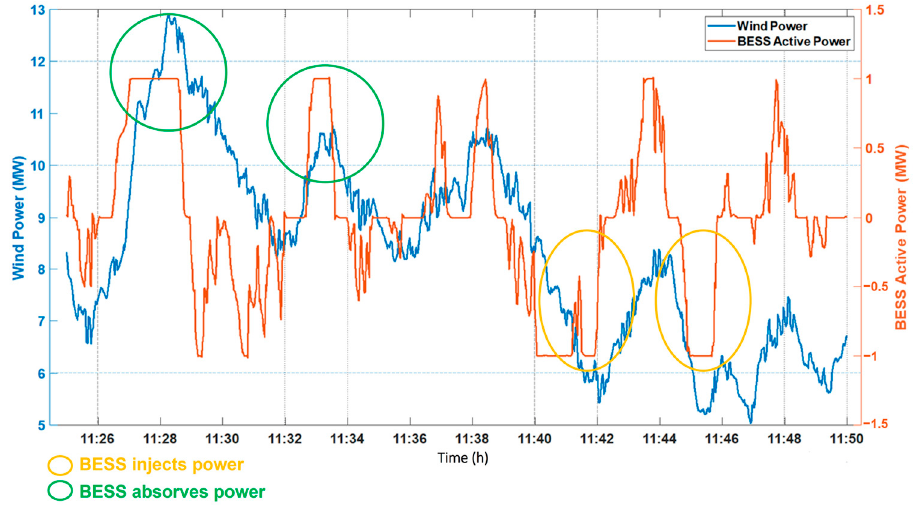
Figure 14. Power factor smoothing performed by BESS. Measurement performed on 19 October 2021. Table 3. Main indicators of power factor smoothing on 19 October